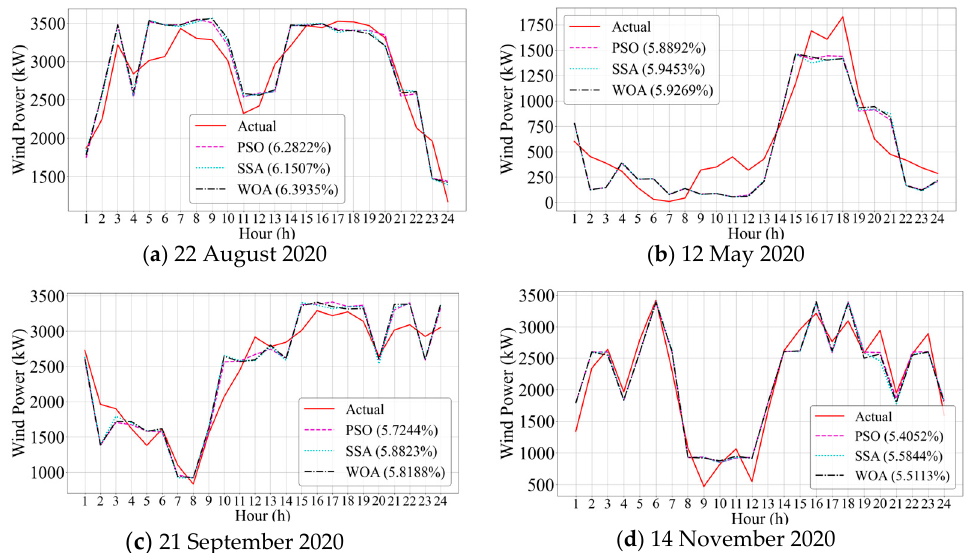
Figure 14. The curves for forecasting results for 4 different testing days using ensemble methods. Table 9. Forecasting errors for single and ensemble models using proposed corrected